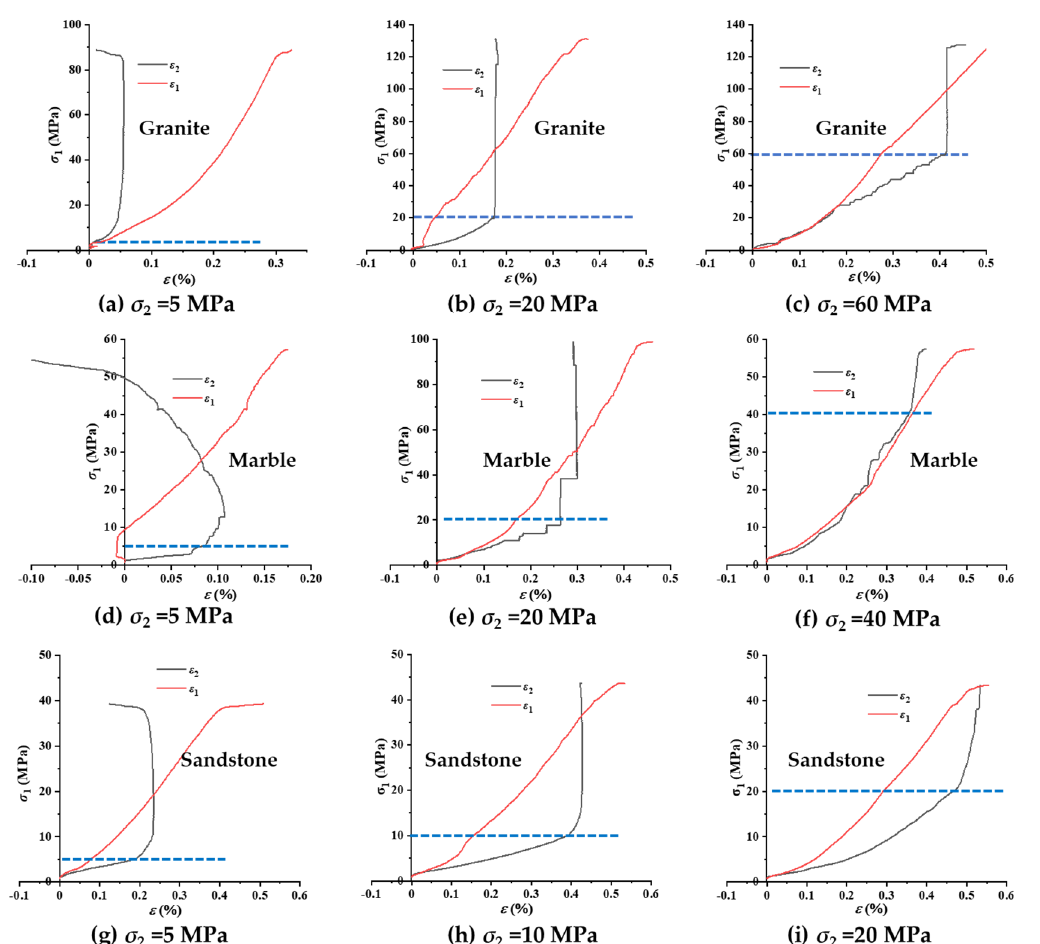
Figure 7. Lateral strain curves: ( a – c ) granite; ( d – f ) marble; ( g – i ) sandstone.